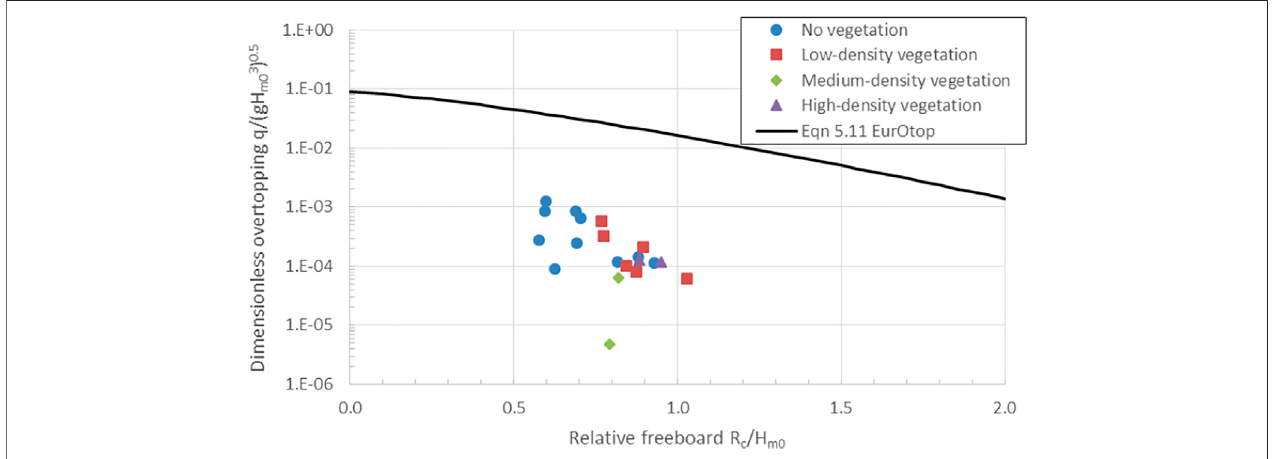
FIGURE 15 | Wave overtopping at four identical dykes for different vegetation